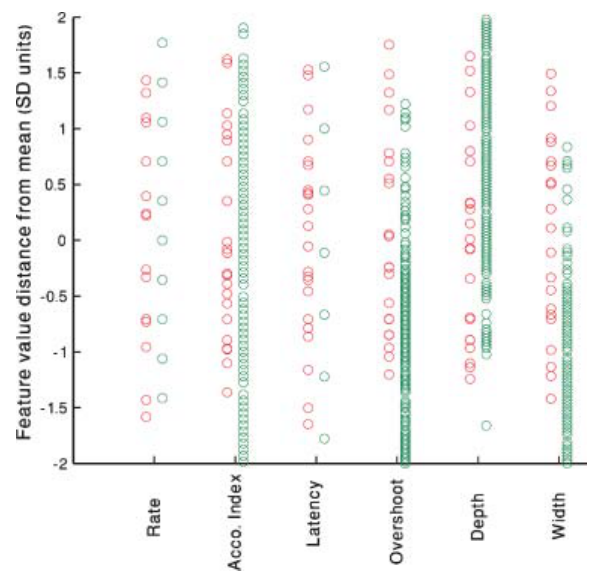
Figure 6. Experimental versus model variability – accommodating neu- rons . For each of the five cells shown in Table 2 , the values of each feature for the 225pA step current is extracted for all repetitions. The mean of the feature value for each cell is subtracted and the result divided by the SD to arrive at the normalized distance from mean. All repetitions of all five accommodating cells have been pooled together and are displayed for each feature separately (red circles). The same process is repeated for the single repetition available for each of the 300 parameter sets that passed the 2 SD criterion (green circles) at the end of the fitting process of the accommodating exemplar (AC 5 Table 2